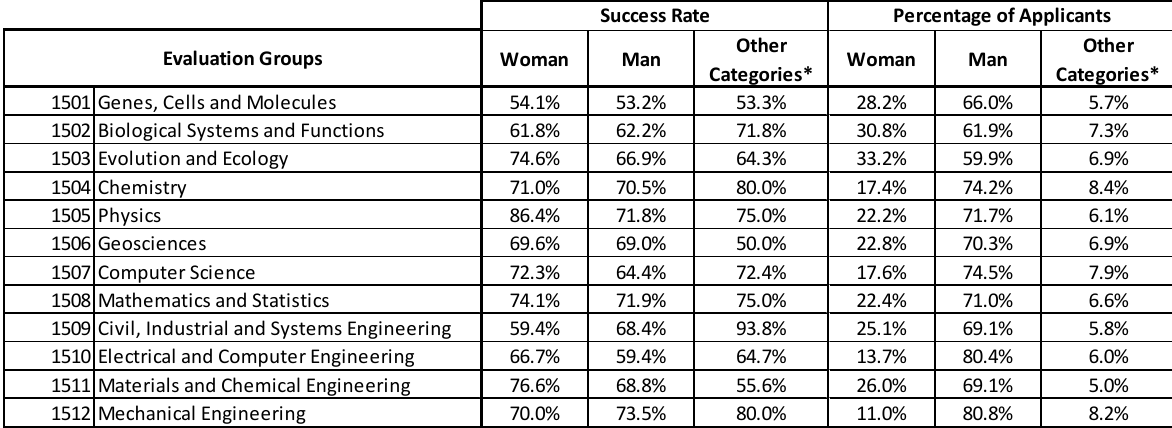
Discovery Grant Success Rate by Gender and Evaluation